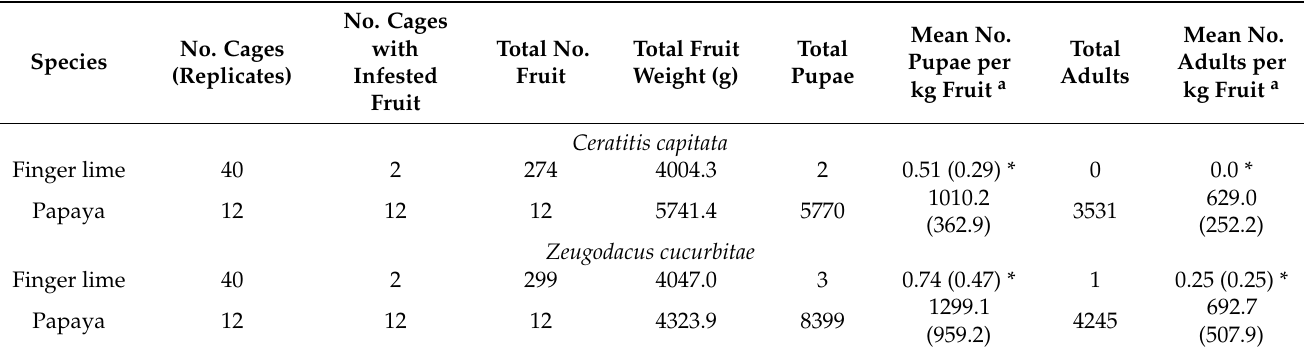
Table 3. Adult emergence from finger lime fruit by Ceratitis capitata and Zeugodacus cucurbitae in no-choice cage exposures with 50 gravid flies for 24